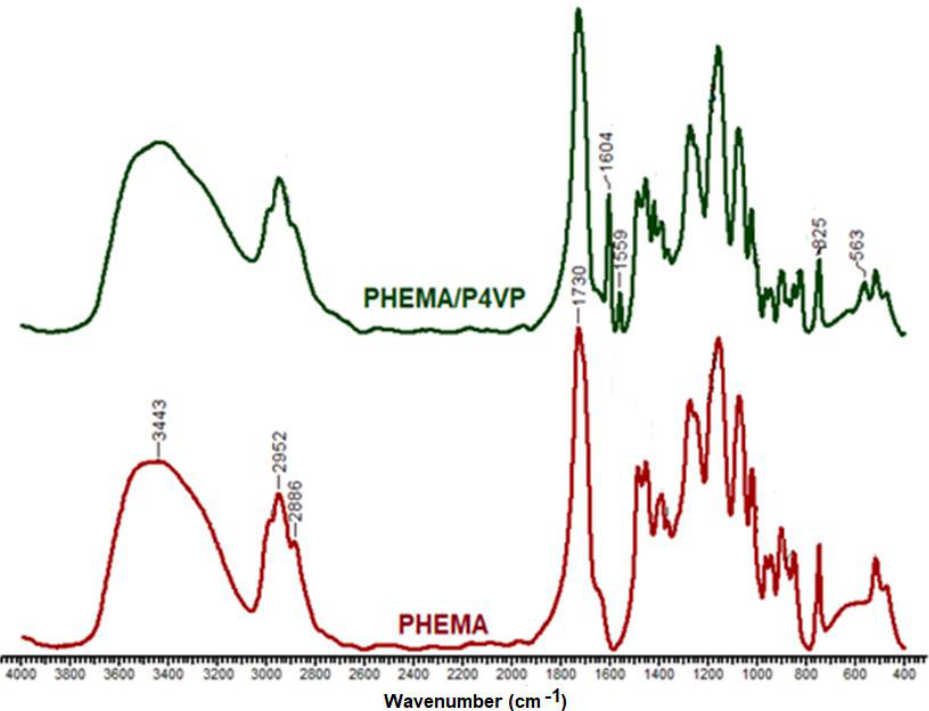
Figure 10. FT-IR spectra of PHEMA and semi-IPN based on PHEMA and P4VP.